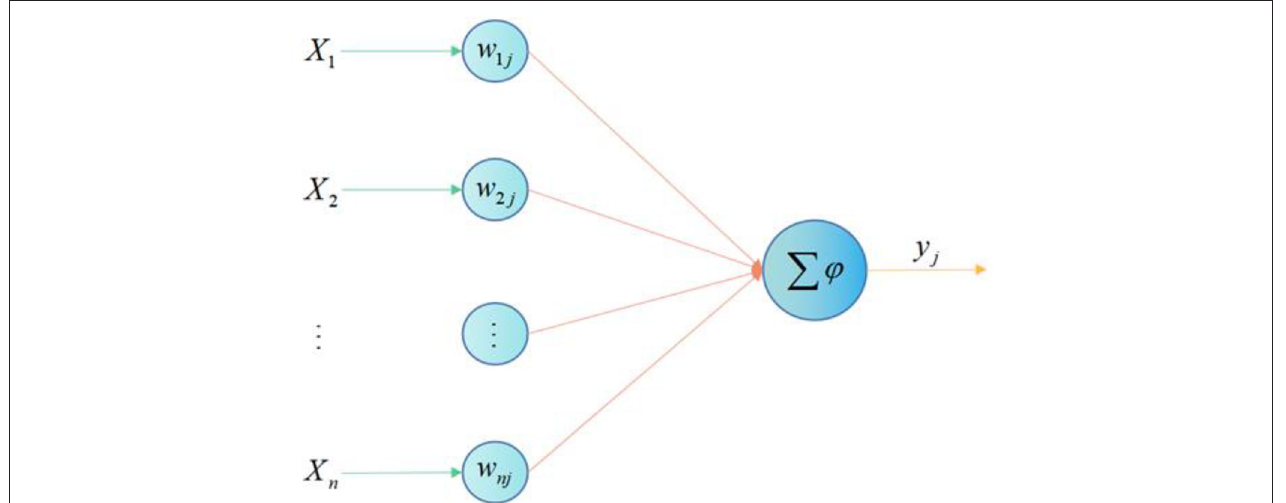
FIGURE 1 | Neuron